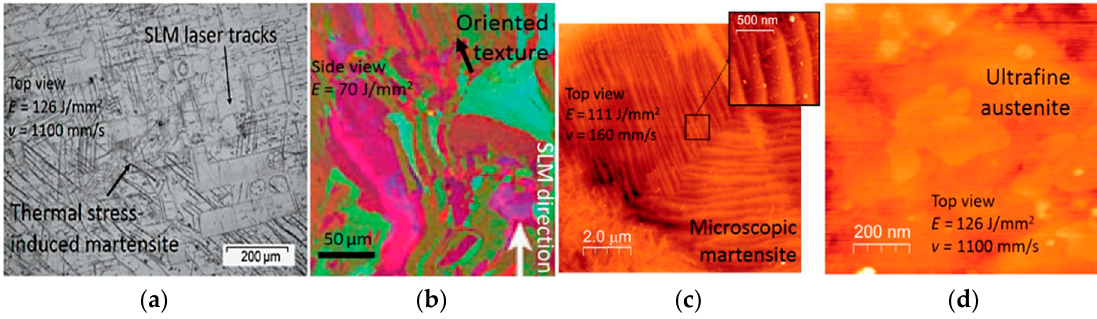
Figure 10. ( a ) SLM laser tracks having stress-induced martensite due to high thermal stresses; ( b ) formation of fine austenite sub-grains along SLM build direction [42]; ( c ) AFM image showing fine internally twinned martensitic structure; ( d ) AFM image showing ultrafine austenite sub-grains [1].